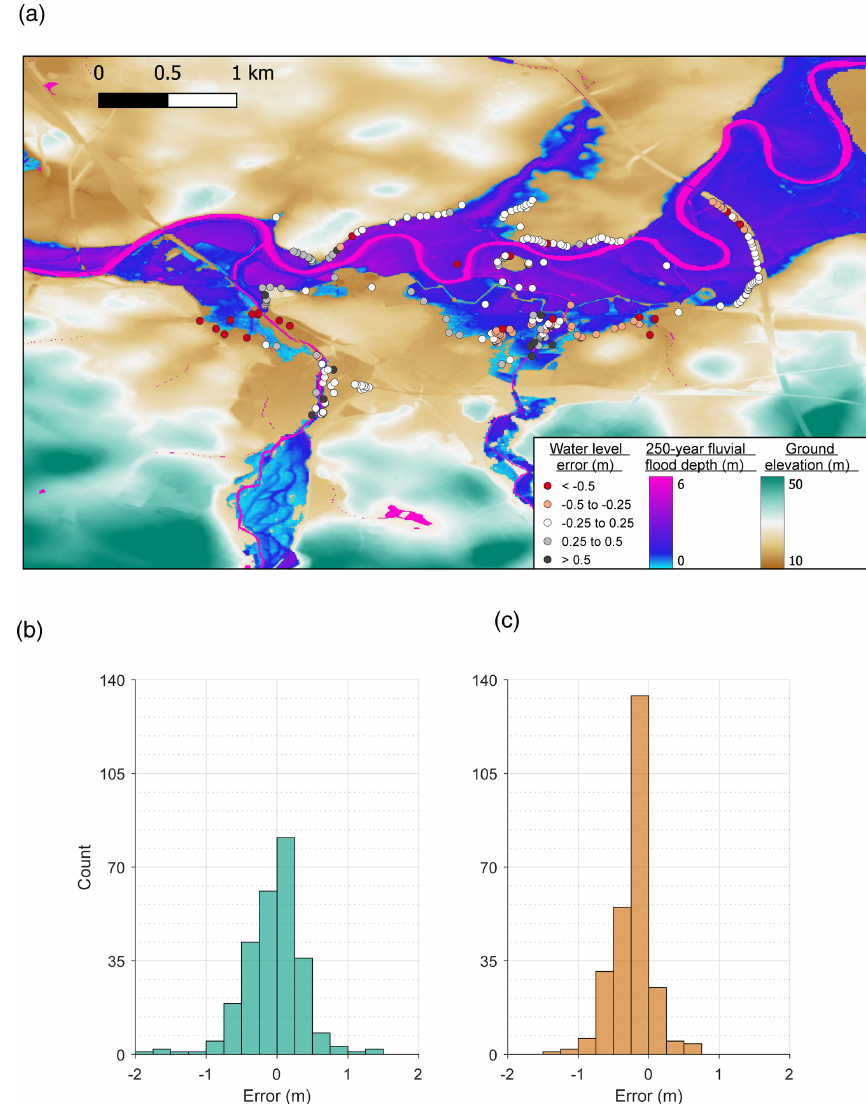
Figure 3. (a) Model predicted 1-in-250-year water depth and extent for Carlisle, showing location of observed maximum water elevations colour-coded by error magnitude; (b) frequency histogram of errors for the model reported in this paper; and (c) frequency histogram of errors for a 5m simulation using the 1D/2D hydrodynamic model LISFLOOD-FP, built with local flow and bathymetric data and using calibrated friction